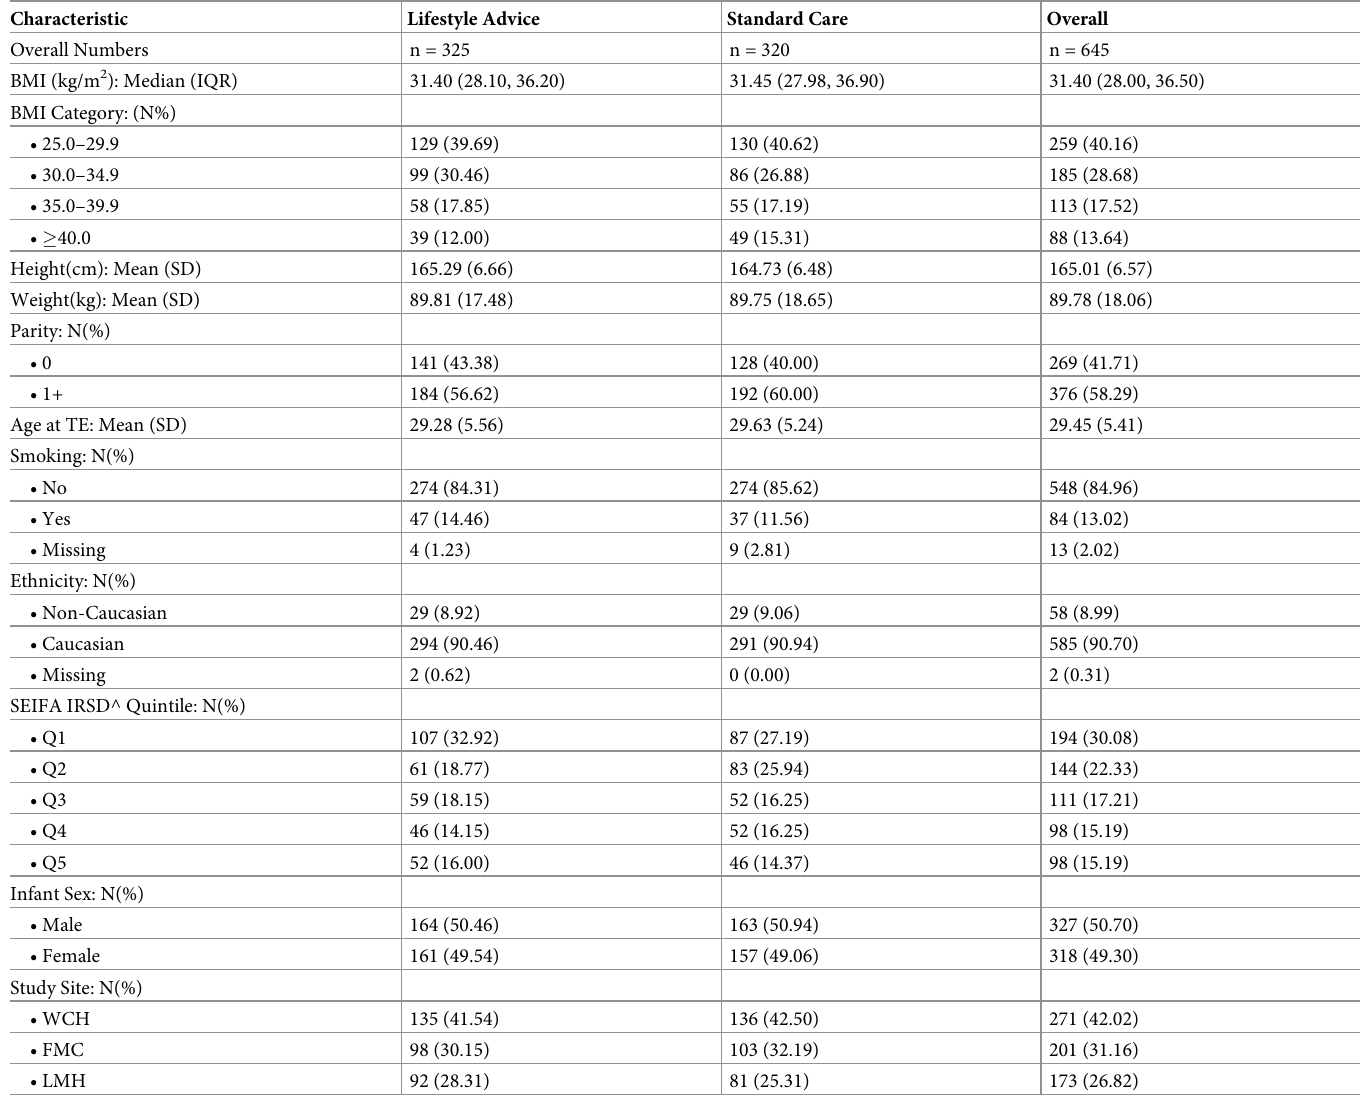
Table 1. Baseline characteristics of